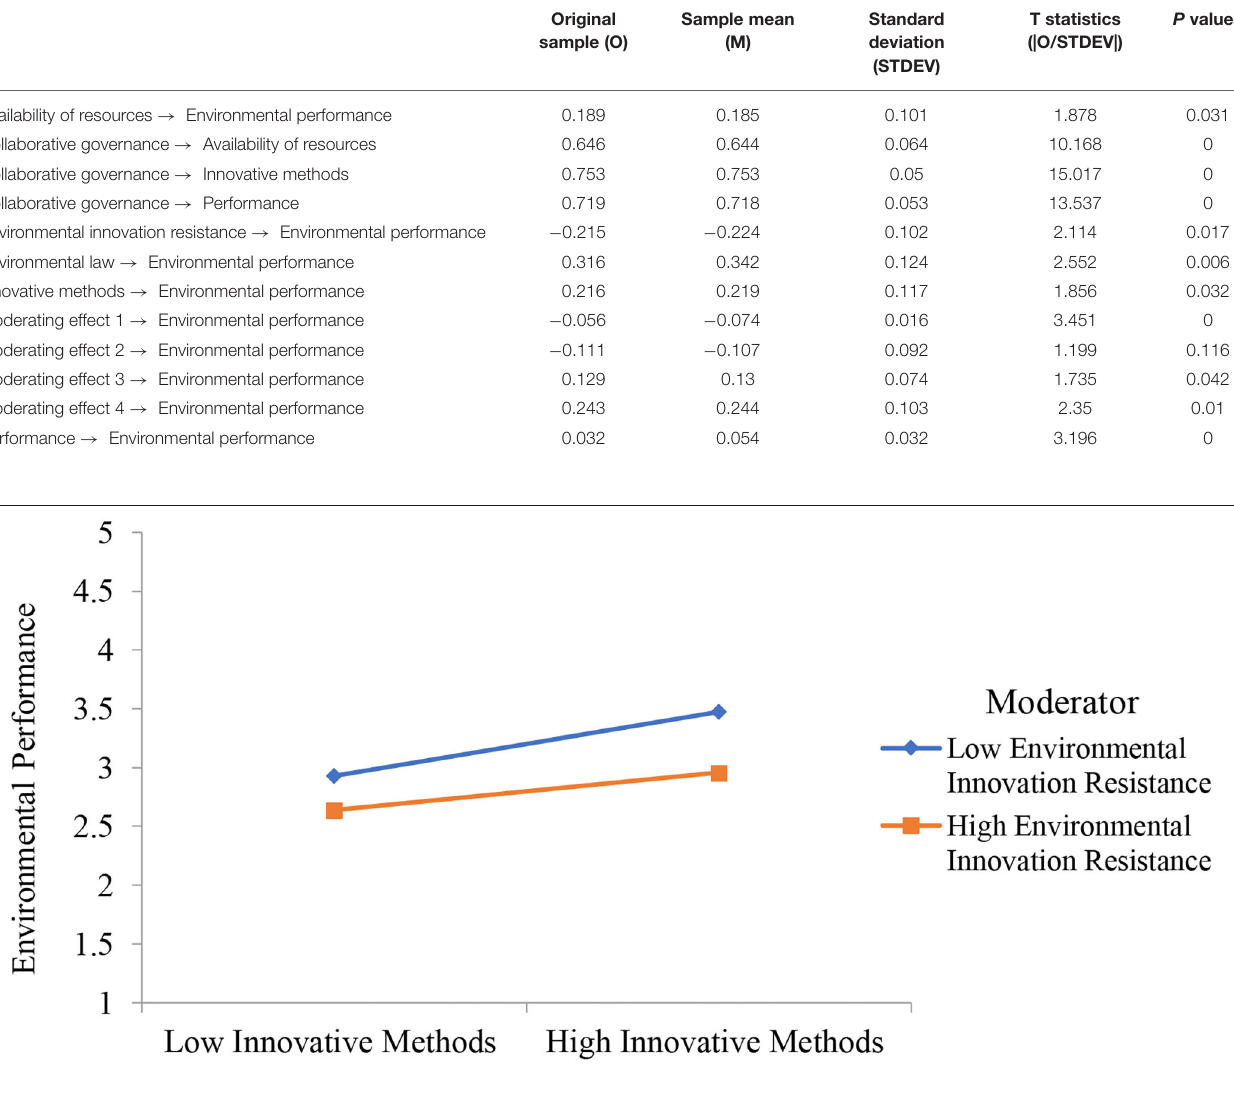
FIGURE 4 | Moderation effect of environmental innovation resistance weakens the relationship between innovative methods and environmental